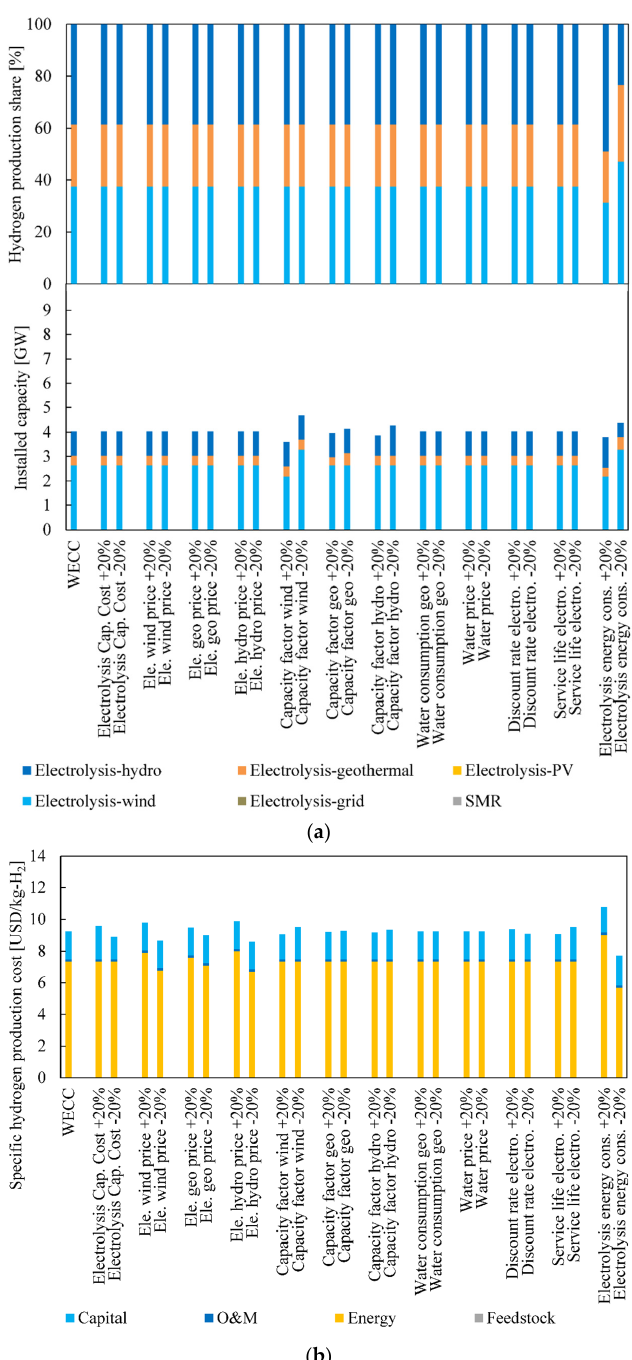
Figure 8. Sensitivity analysis of the hydrogen system performance in the Water-Energy-Carbon-Cost scenario for a cradle-to-gate CO 2 intensity of 0 kg-CO 2 /kg-H 2 CO 2 . ( a ) Hydrogen production share and installed capacity; ( b ) specific cost of hydrogen production.